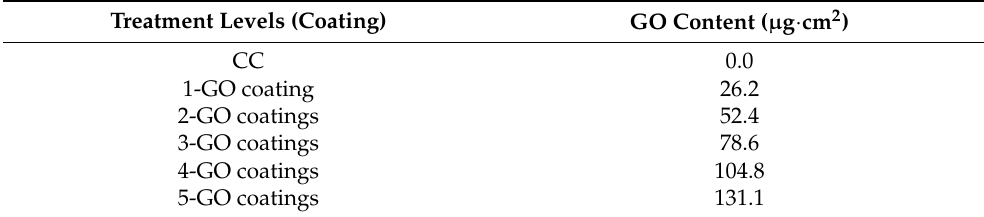
Table 2. Treatment levels and surface content of each level. Treatment Levels